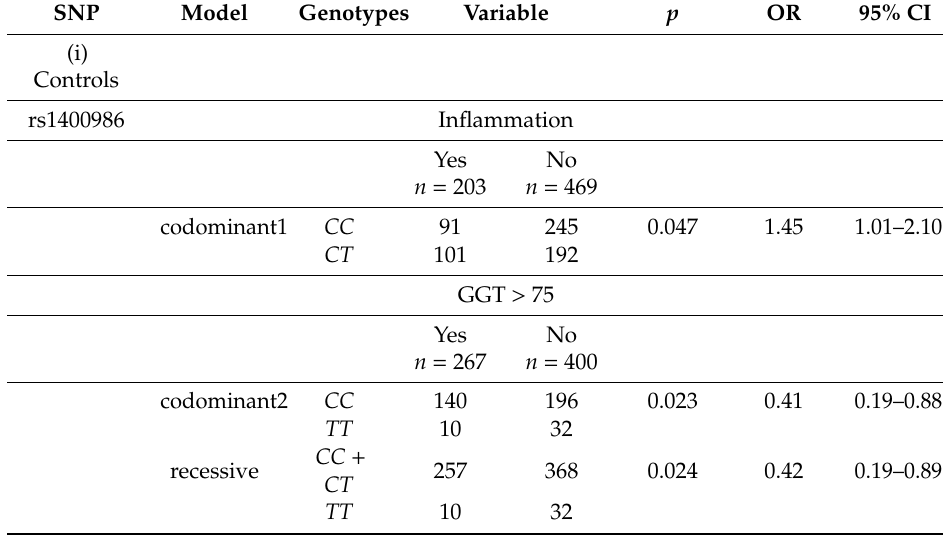
Table 4. Association among IL-20 gene polymorphisms and cardiovascular risk factors in controls and SA